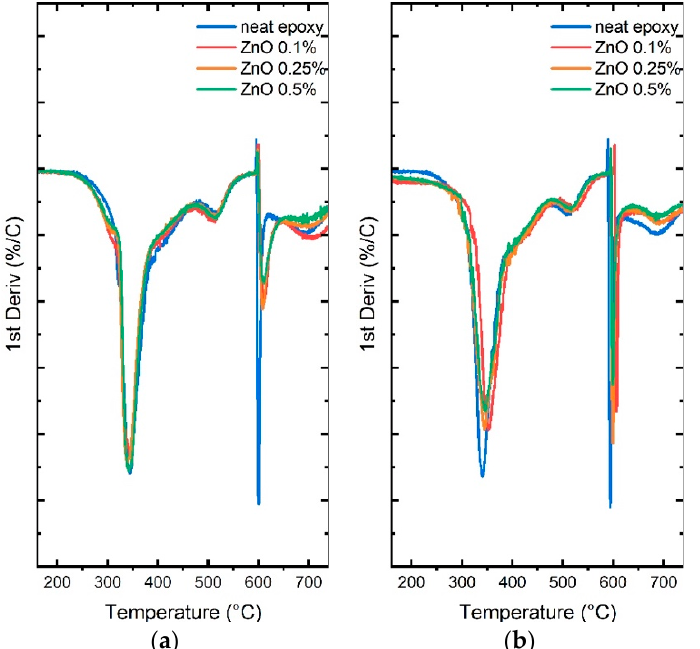
Figure 4. DTG plots corresponding to ( a ) epoxy-ZnO composites before irradiation, ( b ) epoxy-ZnO composites after irradiation.